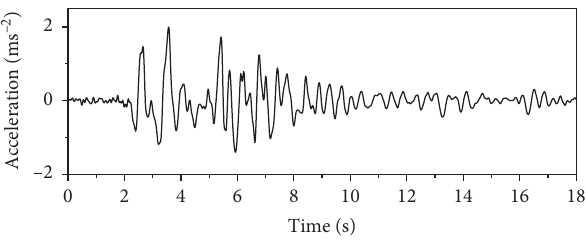
Figure 8: Input seismic wave of the